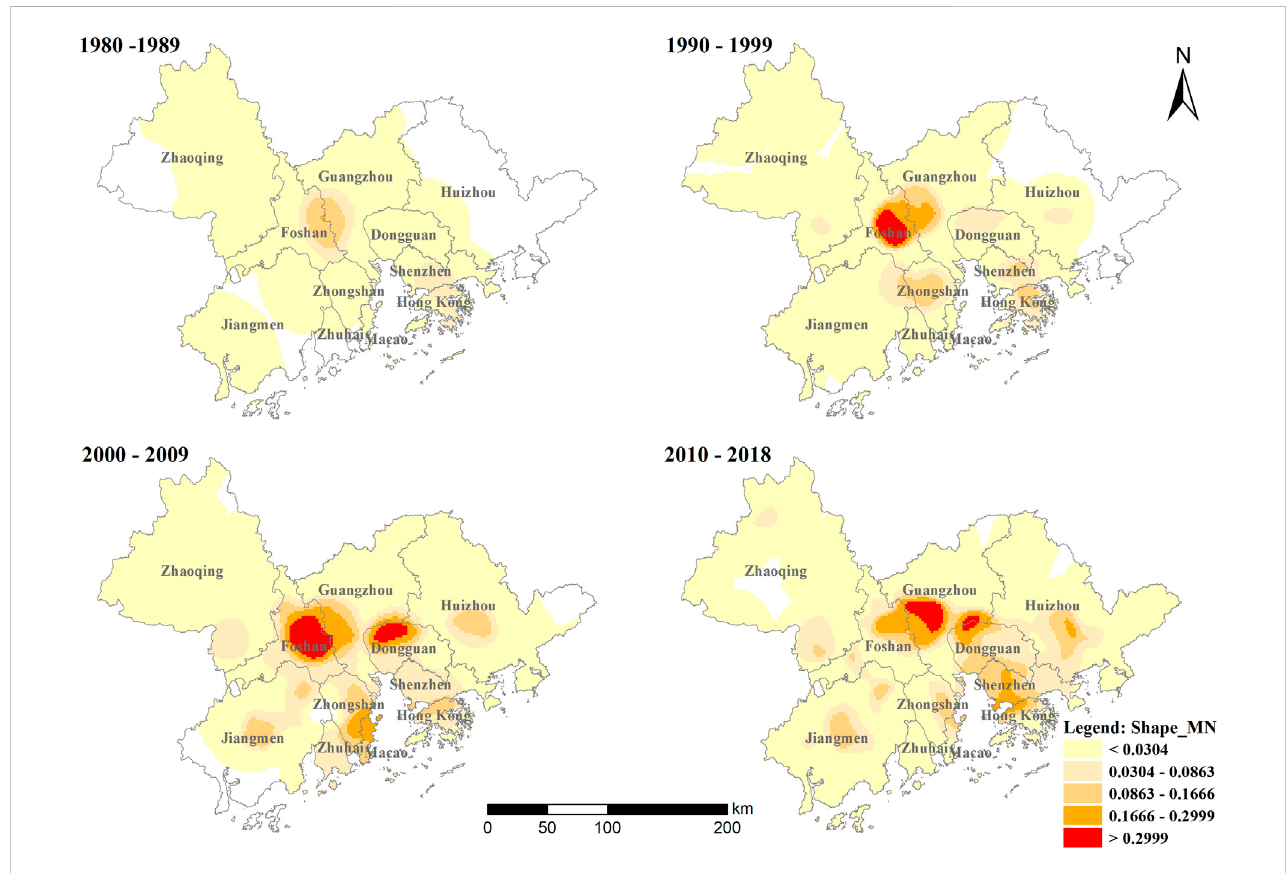
FIGURE 6 Spatial distribution of regression coef fi cients for Shape_MN during 1980 –